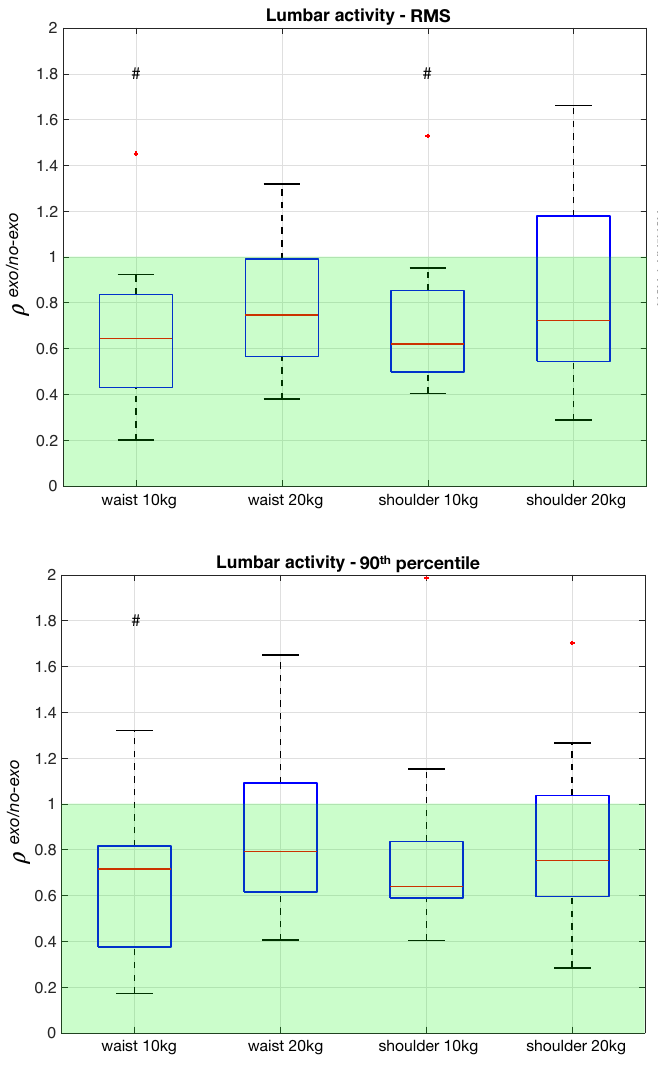
Figure 3. The population distribution of the ratios ρ for RMS and 90th percentile spinal muscle activity are represented via boxplots. On each boxplot (one box for each combination of pulling height and box weight), the central line is the median value, the edges of the box are the 25th and 75th percentiles, the whiskers extend to the most extreme data points considered to be not outliers, and the outliers are plotted individually. The green areas indicate the regions where ρ < 1 (i.e., exo assistance results in a ( 1 − ρ i ) % reduction of the muscle activity with respect to the no-exo assistance mode). # indicates a statistically significant difference with a distribution of ones. As regards the assistance provided by the exoskeleton, the maximum torque values averaged between participants (with standard deviation) are 24 ( ± 7), 27 ( ± 5), 24 ( ± 6), and 26 ( ± 5) Nm, respectively, for the four conditions, i.e., pulling at waist height 10 kg, waist height 20 kg, shoulder height 10 kg, and shoulder height 20 kg. In these